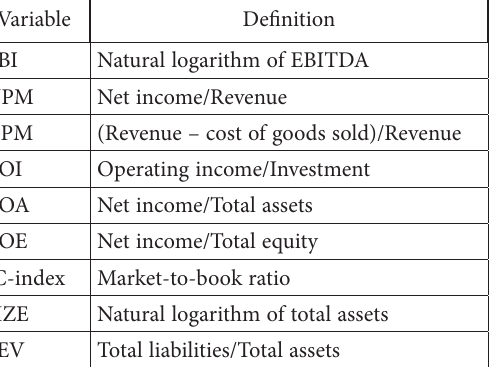
Table 2. Variable